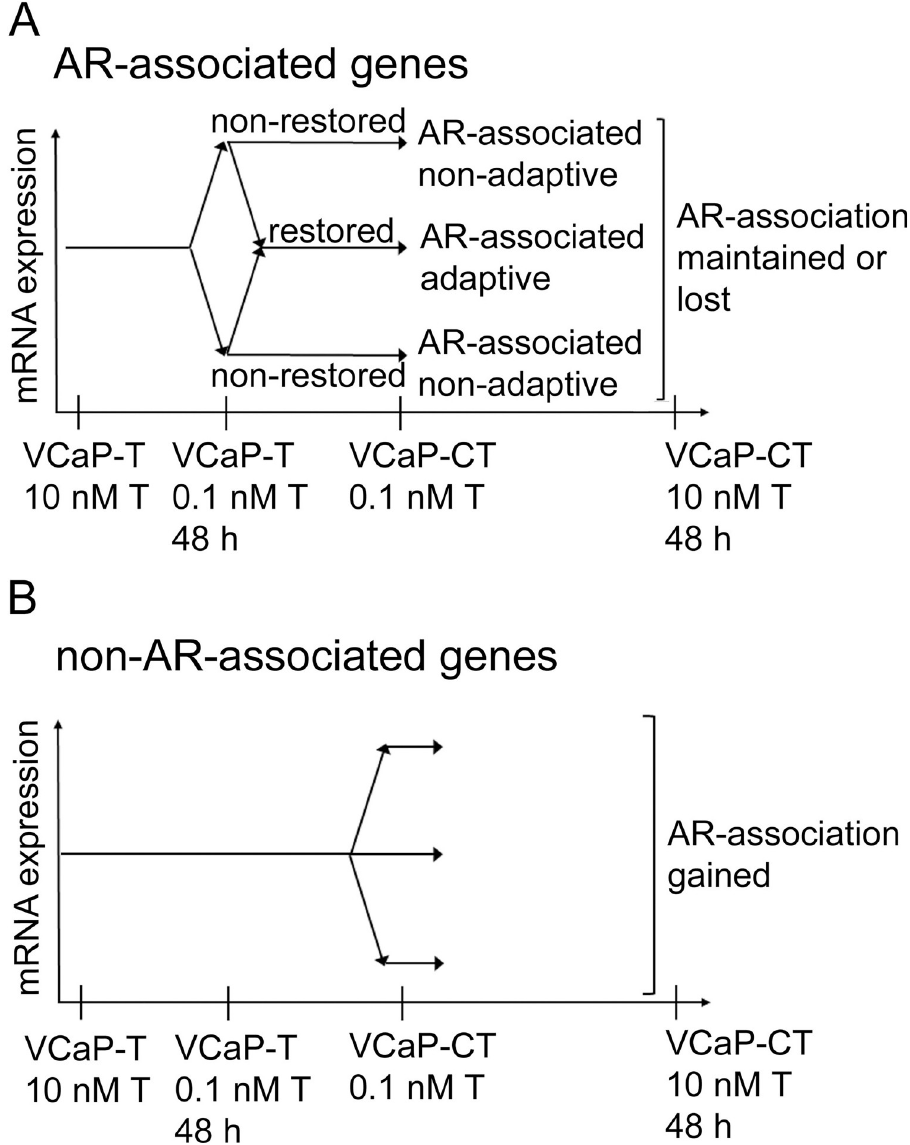
Fig 4. Schematic illustration of the categorization of differentially expressed genes in VCaP-T and VCaP-CT cells. (A) AR-associated genes were identified by treating VCaP-T cells with low T concentration (0.1 nM) for 48 h. These AR-associated genes were further categorized to genes that were adaptive (expression restored) or non-adaptive (expression non-restored) in VCaP-CT cells. Whether the AR-association of the genes was lost or maintained during the acquisition to low T concentration, was assessed by treating VCaP-CT cells with 10 nM T for 48 h. (B) Genes that were not T-regulated in VCaP-T cells were categorized to non-AR-associated genes. Whether the AR-association of the genes was gained or not during the acquisition to low T concentration, was assessed by treating VCaP-CT cells with 10 nM T for 48 h. genes. Phospholipase A2 activity and lipid transport were shared between the AR-associated adaptive and non-adaptive genes.